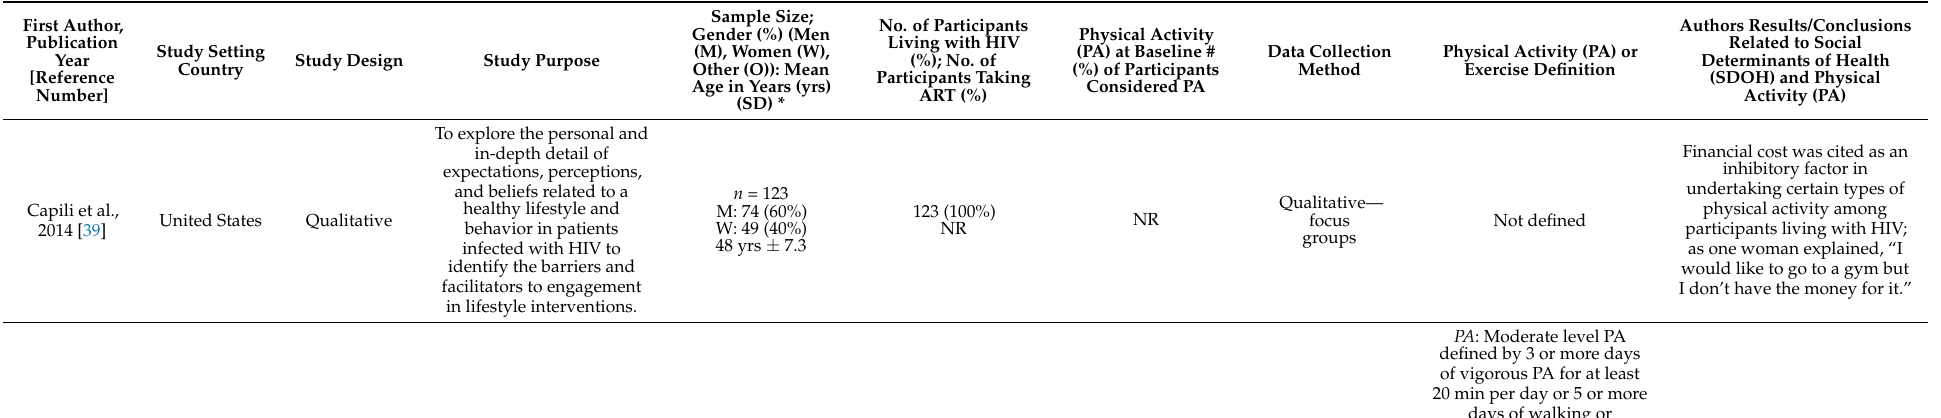
Table 1. Characteristics of included articles ( n =